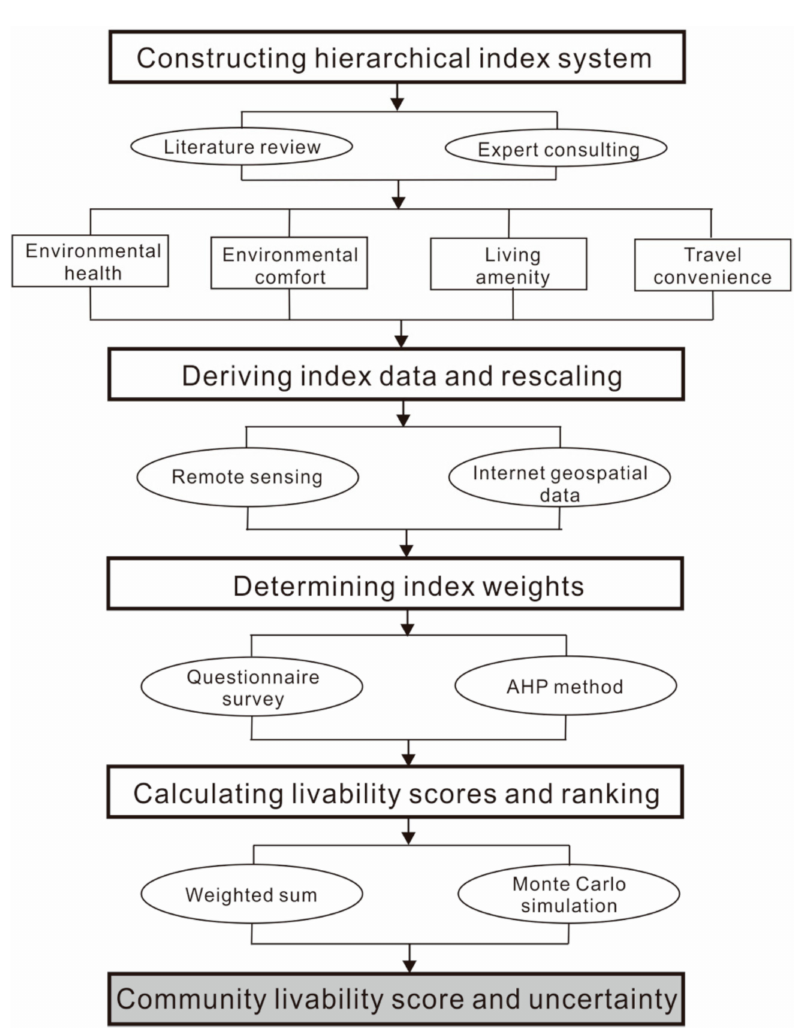
Figure 2. Procedures to develop the livability assessment model. The four steps are shown in the boxes with the bold